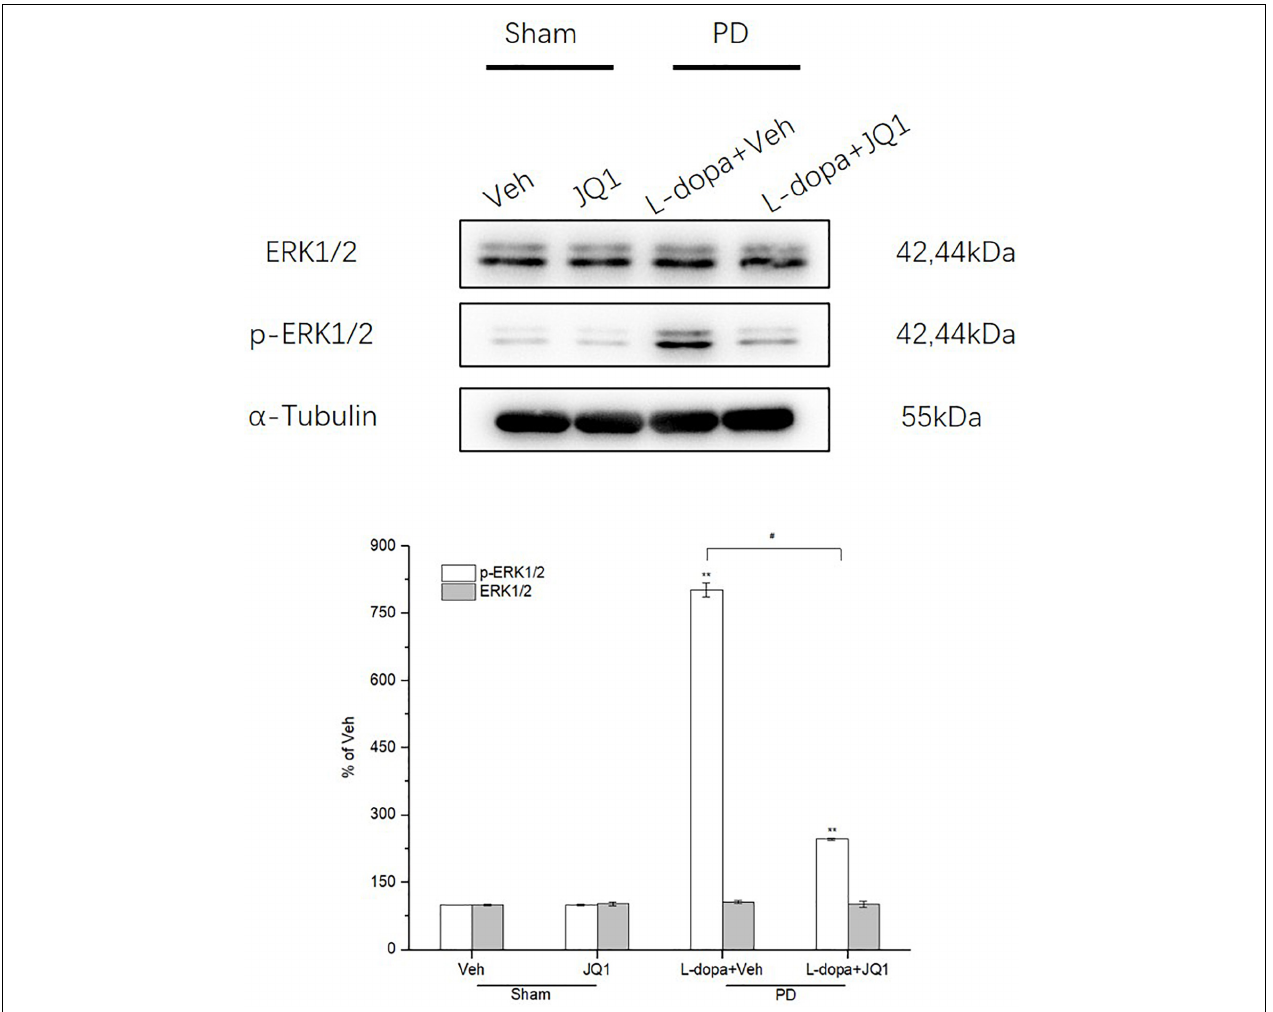
FIGURE 5 | Changes in the expression of ERK1/2 and its phosphorylation extracted from the saline- or 6-OHDA-lesioned striatum after 21 days of administration. Both the L-dopa and L-dopa + JQ1 treatment groups showed an aberrant increase in the protein level of phoshpo-ERK1/2 in the 6-OHDA-lesioned striatum of rats after 21 days of treatment ( p < 0.001 vs. Veh group). Moreover, the increase in phospho-ERK1/2 in the L-dopa treatment group was greater than that in the L-dopa + JQ1 treatment group ( p < 0.01). In addition, JQ1 barely affected the expression of phospho-ERK1/2 in the saline-lesioned striatum in the JQ1 treatment group ( p > 0.05 vs. Veh group). The ERK1/2 protein level remained unchanged among the four treatment groups. All the aforementioned protein levels expressed relative to α -tubulin levels. The data are expressed in terms of mean ± SD and as a percentage of the Veh group. ** p < 0.001 vs. Veh group, # p < 0.01 vs. L-dopa treatment group ( n = 3 per